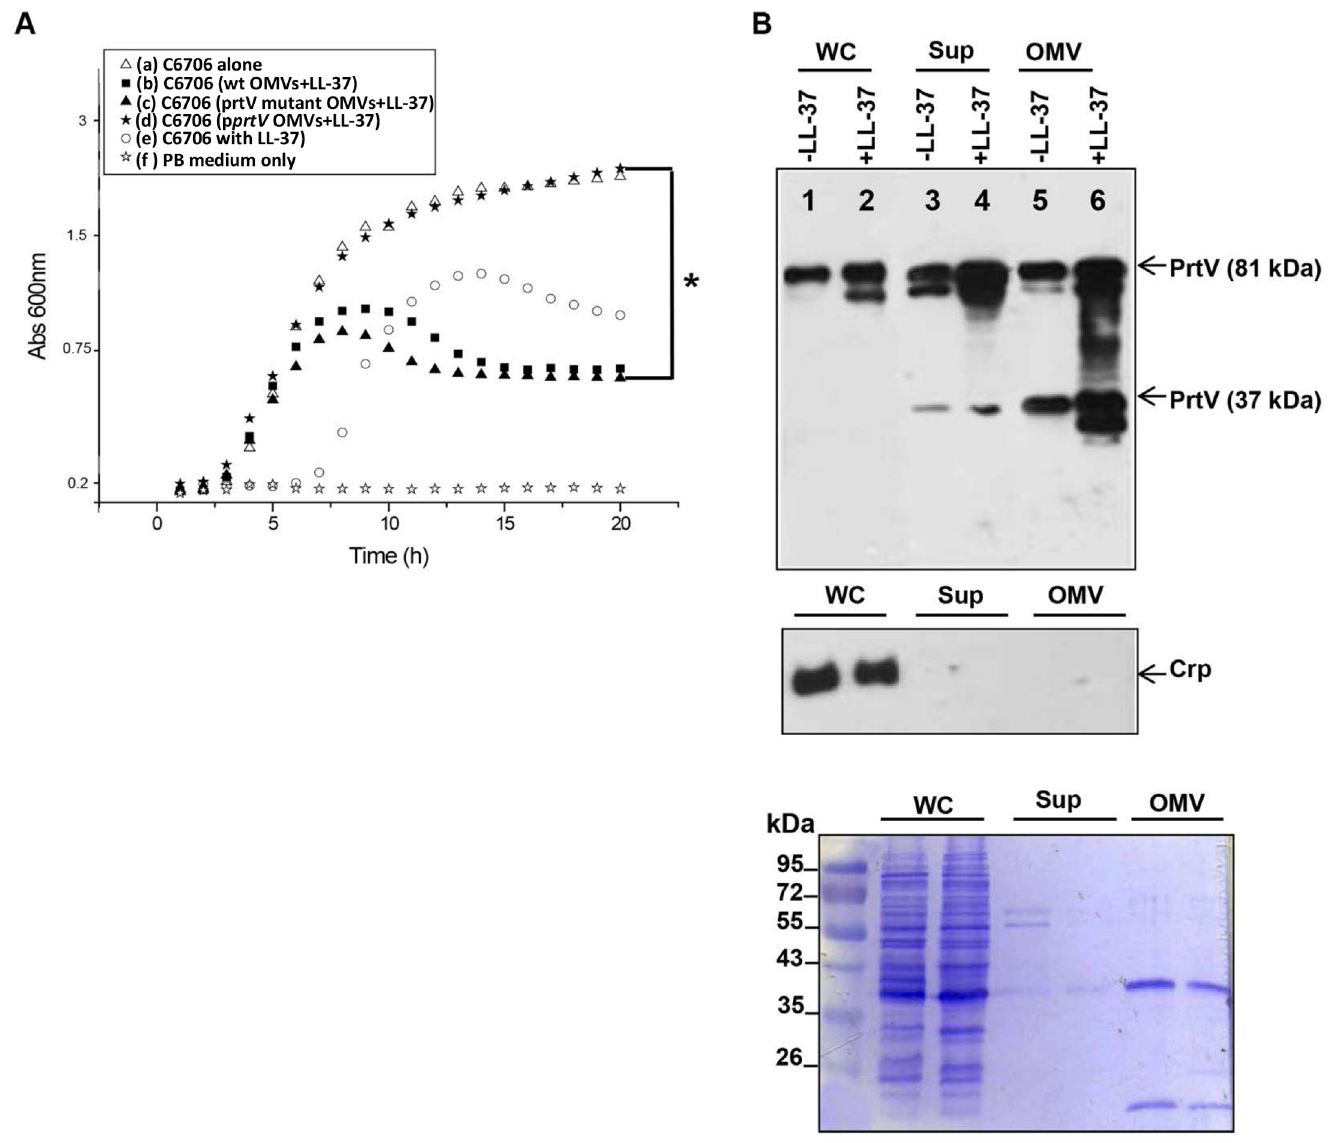
Fig 9. Analysis of role of OMV-associated PrtV in LL-37 resistance. (A) PrtV protein contributes to bacterial resistance against LL-37. V . cholerae O1 El Tor strain C6706 was grown in the presence of OMVs pre-incubated with a sub-lethal concentration (25 μ g/ml) of the antimicrobial peptide LL-37. Bacterial growth was monitored spectrophotometrically at 600 nm for 20 h at 30°C. C6706 was grown under the following conditions: Open triangle (a) C6706 without LL-37, closed rectangle (b) in the presence of wild type OMVs and LL-37, closed triangle (c) in the presence of Δ prtV OMVs and LL-37, closed star (d) in the presence of OMVs from Δ prtV strain carrying the cloned wild type allele of prtV in pBAD18 and LL-37, open circle (e) in the presence of LL-37 and no OMVs, open star (f) no bacteria, poor broth (PB) medium only. A statistically significant growth difference ( * = P < 0.05) was observed between curves (d) and (c). (B) The antimicrobial peptide LL-37 induces more PrtV secretion in V . cholerae . Immunoblot analysis of expression and secretion of PrtV in response to the antimicrobial peptide LL-37. V . cholerae O1 El Tor strain C6706 was grown at 30°C in the presence and absence of a sub-lethal concentration of LL-37 (25 μ g/ml) and samples were collected at OD 600 2.0. Immunoblot was performed using anti-PrtV polyclonal antiserum (upper panel) and anti-Crp polyclonal antiserum to detect Crp, a cytoplasmic protein marker (middle panel). Lanes 1 (without LL-37) and 2 (with LL-37): whole cell lysates; lanes 3 (without LL-37) and 4 (with LL-37): culture supernatants; lanes 5 (without LL-37) and 6 (with LL-37) OMVs. Lower panel: SDS-PAGE and Coomassie blue staining of samples from (A) and (B).